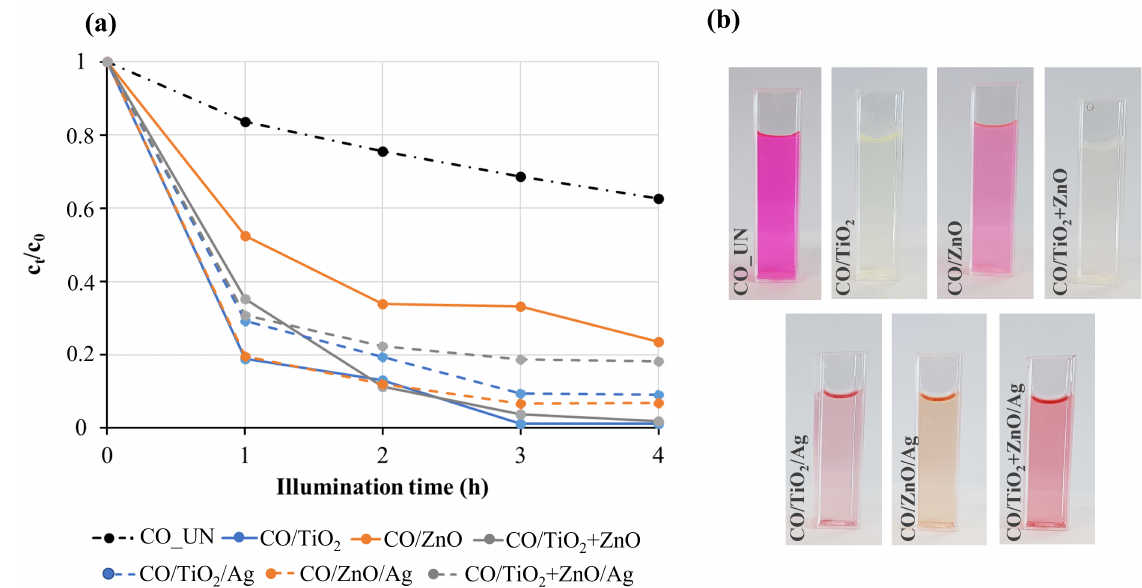
Figure 8. Photocatalytic degradation of Rh B in the presence of the untreated and chemically modified samples after a different illumination time ( a ); digital images of the cuvettes filled with Rh B solution after 4 h of illumination ( b